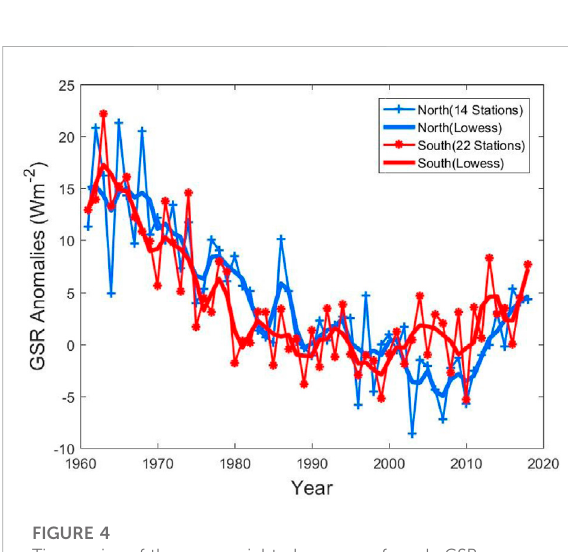
FIGURE 4 Time series of the area-weighted average of yearly GSR anomalies from 14 stations in northern China (blue) and from 22stationsinsouthernChina(red)during1961 – 2018.Originaldata (dot and line) are smoothed by the lowess fi lter (Local regression using weighted linear least squares and a 1st degree polynomial model) (Thick